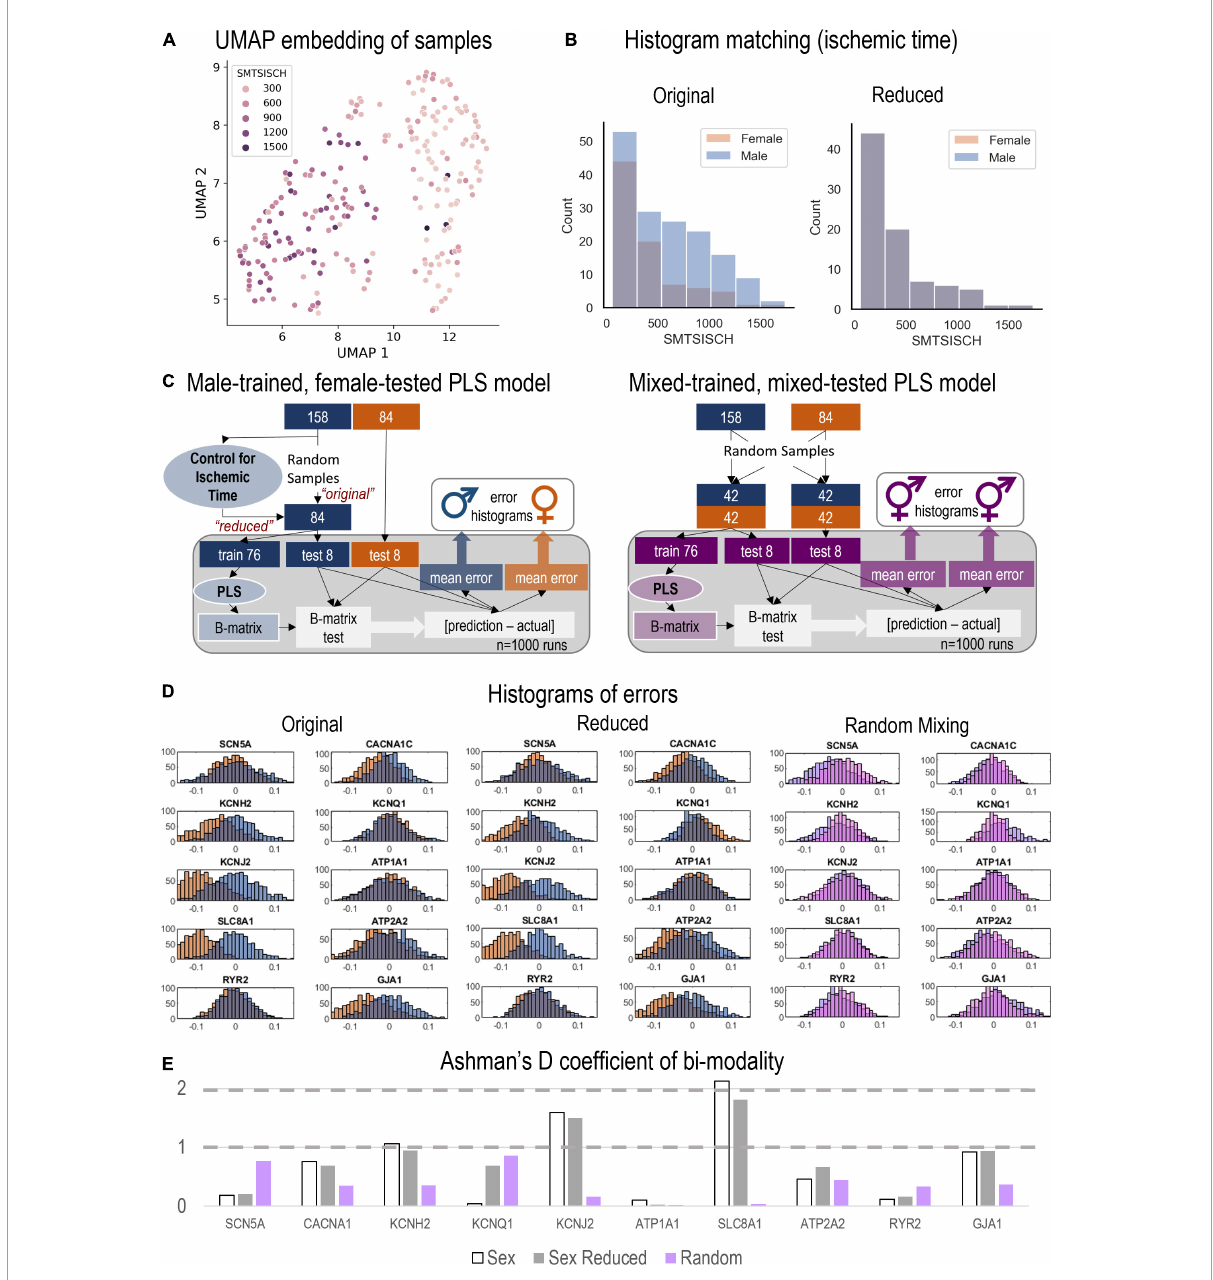
FIGURE5 Monte Carlo (MC) simulations to examine the predictive power of male-trained PLS models when applied to female data. (A) UMAP embedding (dimension reduction) was used to visualize the samples in 2D space, when considering all HDACs, SIRTs, HATs, TFs, and Ion Channels. This representation showed strong role for the total ischemic time (SMTSISCH, colored) in the separation of samples. (B) To eliminate the effects of SMTSISCH as a confounder in the sex-difference analysis, a histogram matching was performed—the histograms show the before and after reduction of the set of male samples to match the female samples based on total ischemic time. (C) (Left) Details on the MC model runs and estimation of errors for male-trained, female-tested PLS models linking histone acetylation modifiers to cardiac ion channels in the LV. Two types of male models (matching the sample size of the female set, 84) were constructed—“original” with randomly selected 84 male samples and “reduced” (with histogram matching for SMTSISCH). (Right) Details on the construction of MC mixed models—trained on mixed data and tested on mixed female-male data. By mixing male and female, the model will have seen both samples and predict both well, assuming that the training samples represent the actual distribution of male and female samples. (D) From the 1,000 runs, the total errors were stored and displayed in histograms for the three types of models depicted in D, respectively. Note systematic shifts in errors in D from the zero-mean center. Left shift (to more negative error values) indicates underestimation of effects by the created PLS model for the respective variable. (E) Ashman’s D coefficient (measure of bimodality, or how distinct the two populations of errors are) was calculated for each of the model results and displayed on the bar plot; higher Ashman’s D values indicate better